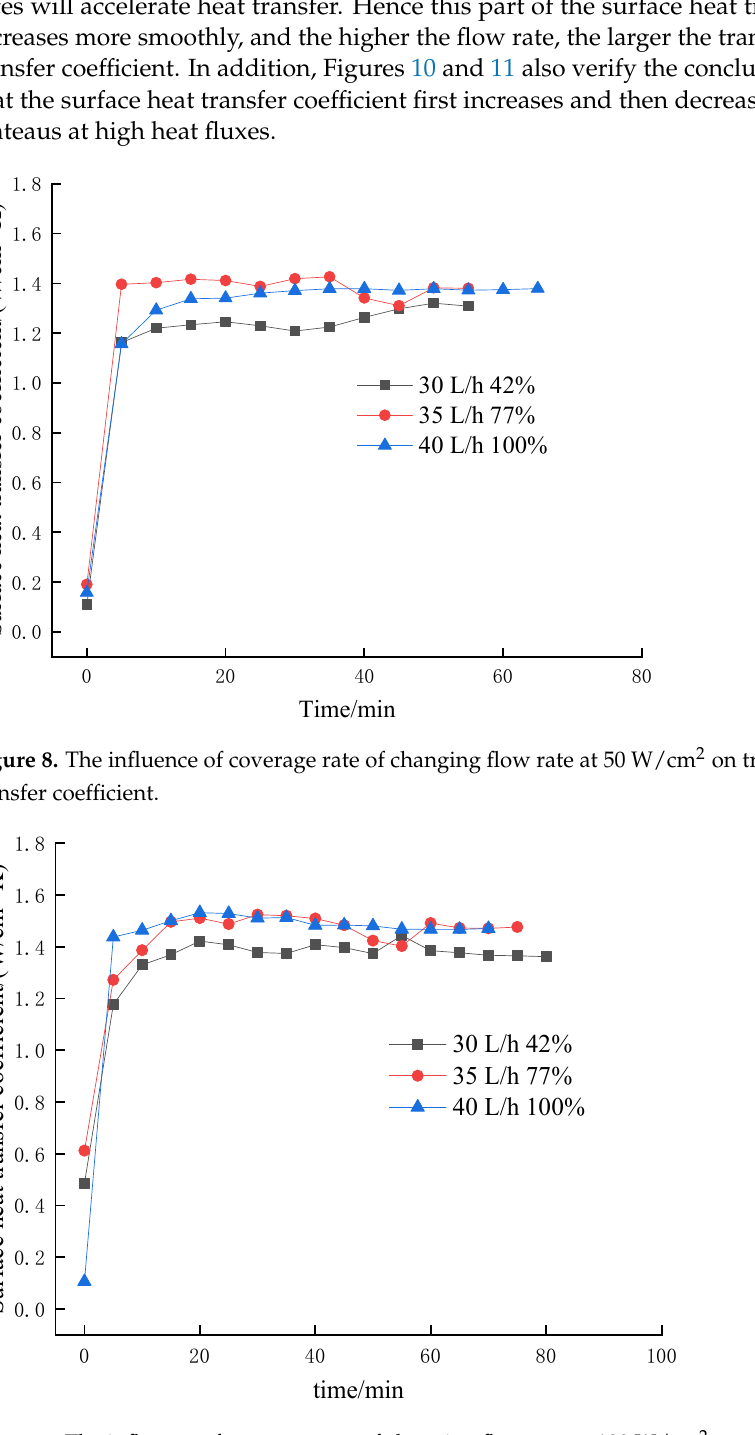
Figure 9. The influence of coverage rate of changing flow rate at 100 W/cm 2 on transient surface heat transfer coefficient.